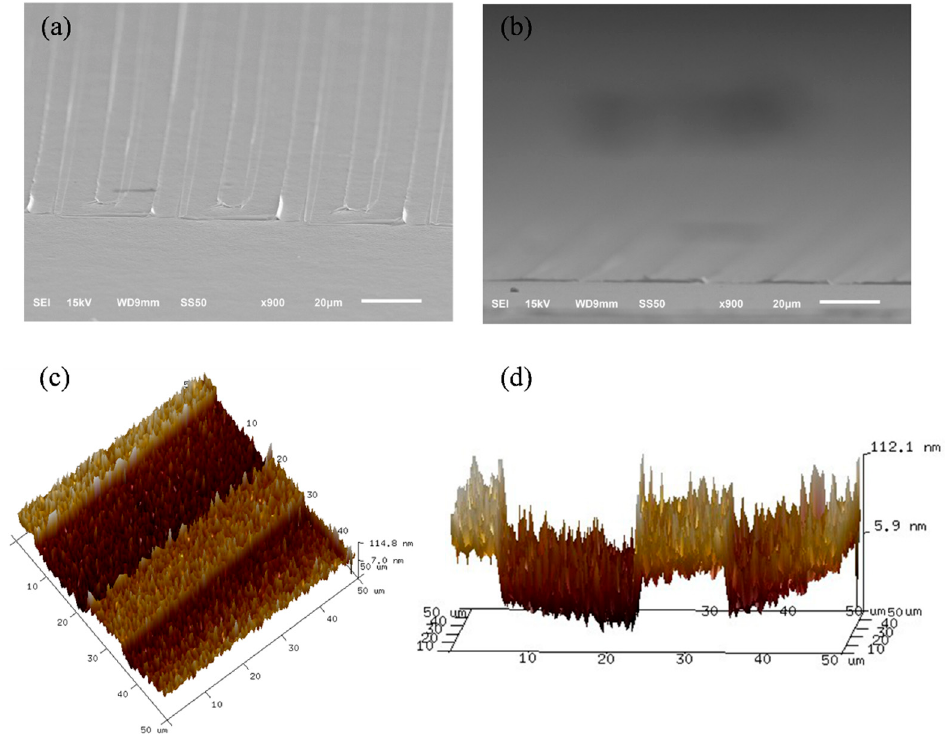
Figure 3. Scanning electron microscope images of the TiO 2 stripe array that is deposited on TiO 2 compact layer at ( a ) 45 ◦ and ( b ) 80 ◦ angles of incidence, respectively. ( c ) Top and ( d ) side views of atomic force microscope images of the TiO 2 strip array that is deposited on TiO 2 compact